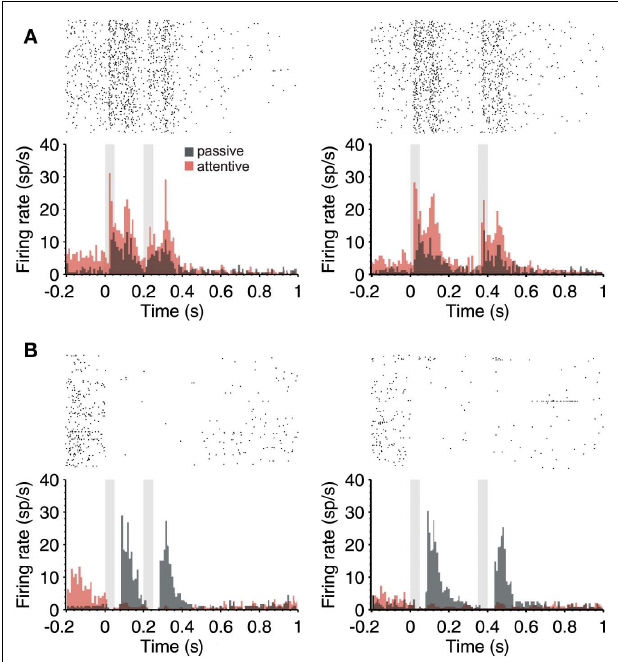
FIGURE 4 |Attention-modulated firing rate in the periods in between auditory stimuli. (A) PSTH (180 trials) of a single neuron during the passive (gray) and attentive (red) task where two identical stimuli (50ms; 80dB; 5322Hz) separated by 150ms (left) and 300ms (right) were delivered. Notice that not only the response but also prominent responses in the absence of stimuli (preceding and between stimuli) are up regulated by attention. (B) Example neuron that had no auditory response, but a prominent and slow response after the termination of auditory stimuli during passive trials.This response was silenced during the attentive trials. However, notice that the activity preceding the first auditory stimulus was increased during attention (in red). In both cases (A,B) , the raster plots correspond to the attentive trials. In all cases, 150 and 300ms intervals were given randomly during the same